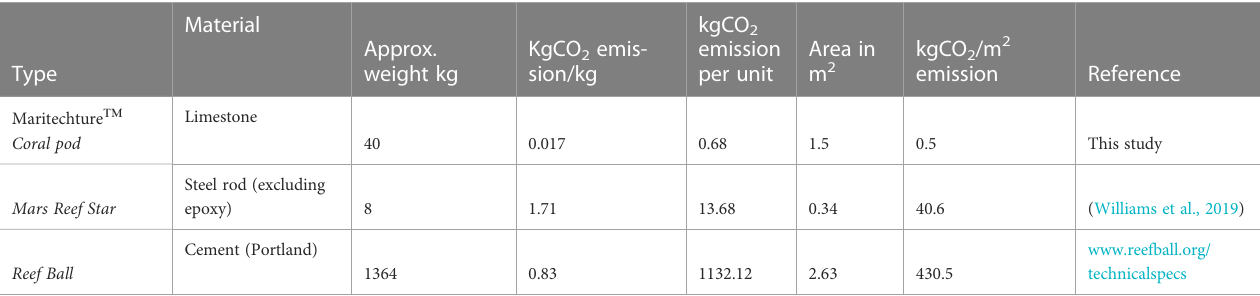
TABLE 1 Carbon footprint of different coral support structures. Greenhouse gases produced associated with construction is estimated based on Hammond and Jones